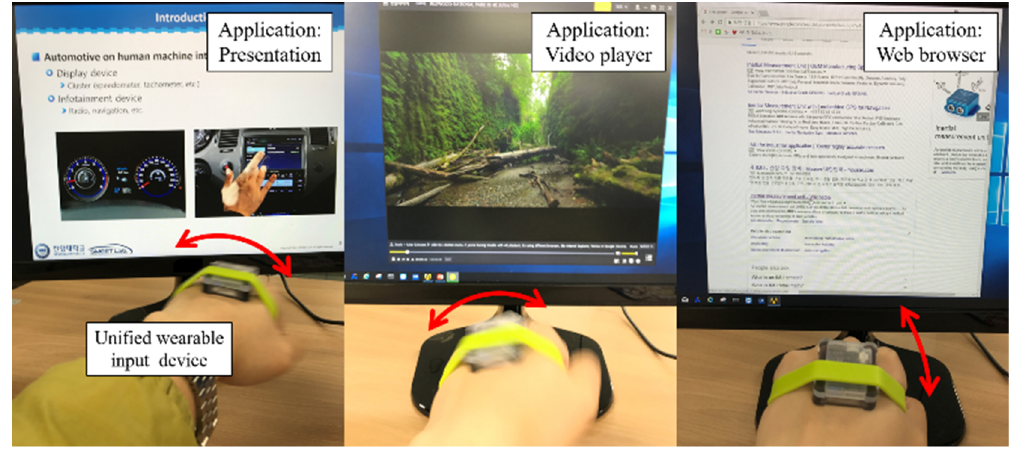
Figure 5. The unified multi-modal input device used for three application programs.